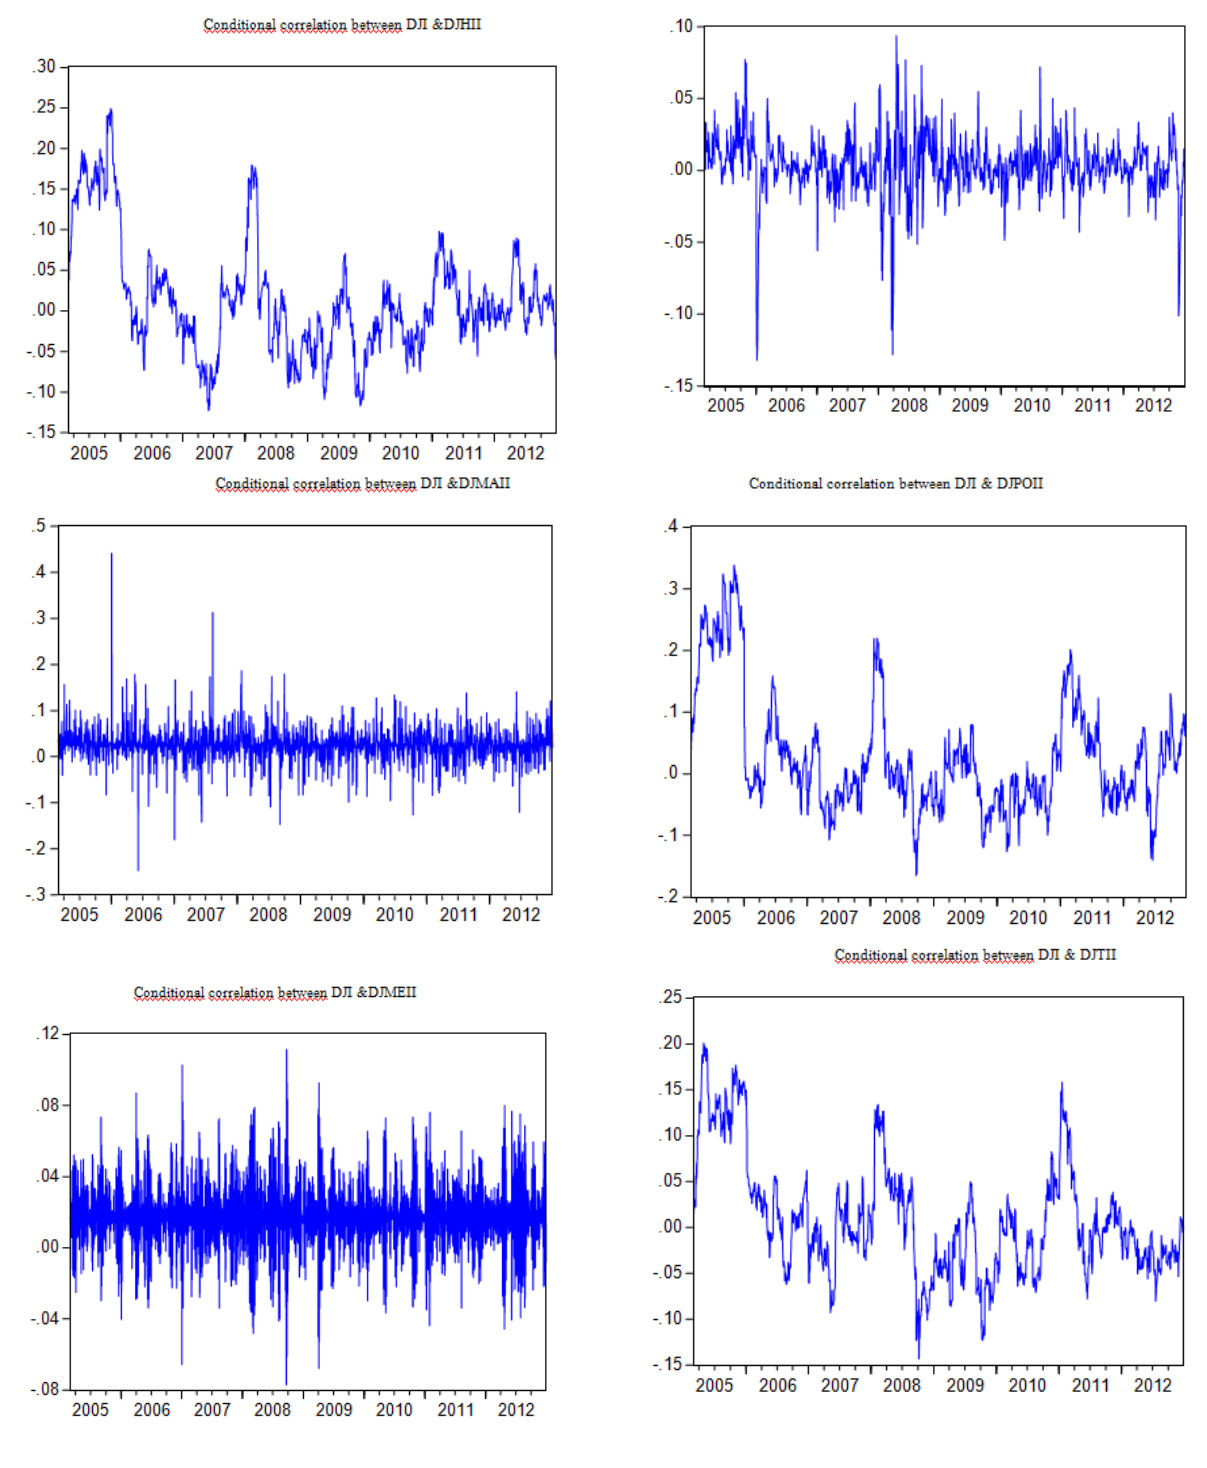
FIG 1: Conditional Correlation between DJI &